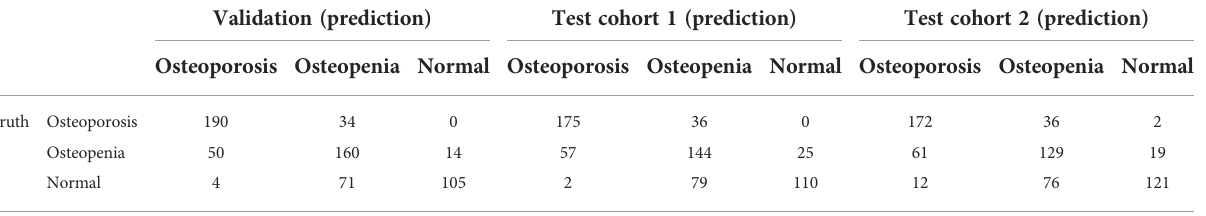
TABLE 3 Confusion matrices of predictions and reference standards in validation and two testing datasets based on the AP+LAT channel. Validation